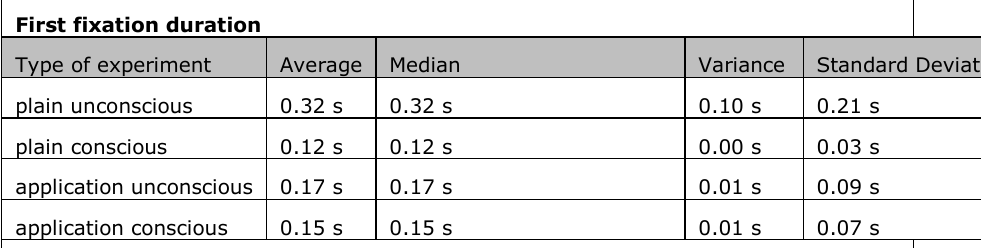
Table 2. Results of the preliminary test run. Experiments are determined by the type of emergency button (plain or application specific) and unconscious and conscious.